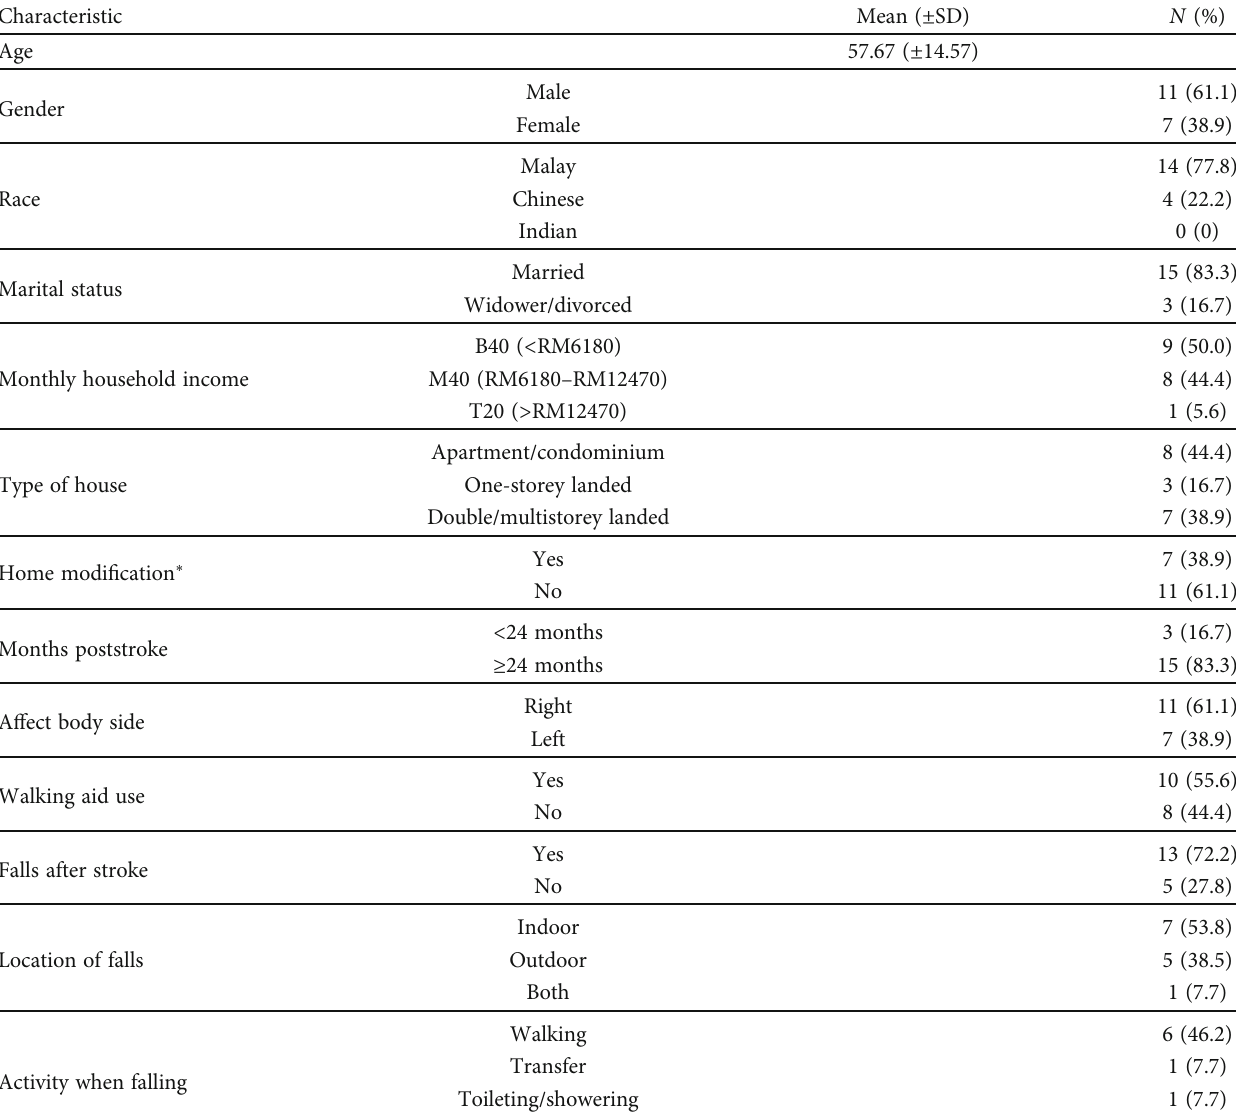
Table 1: Demographics of stroke participants ( N = 18